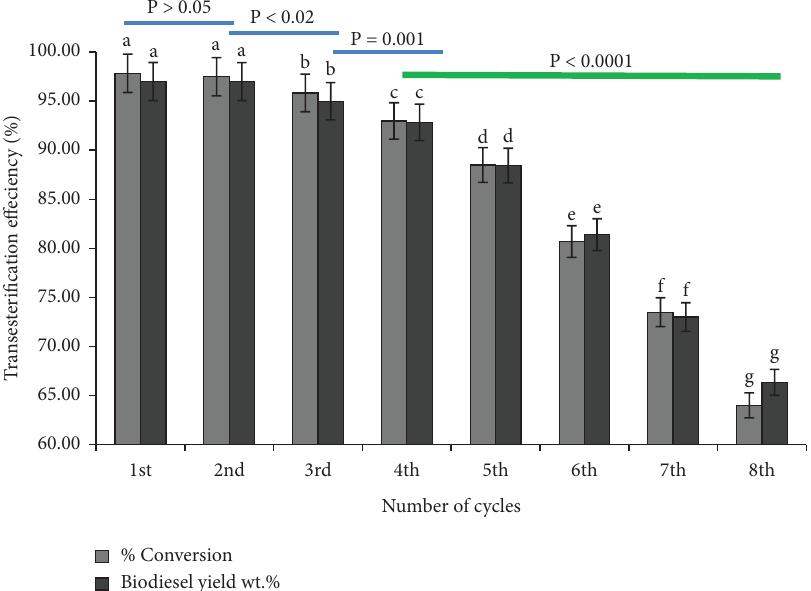
Figure 9: Reusability of the immobilized PSP8 lipase E–NH